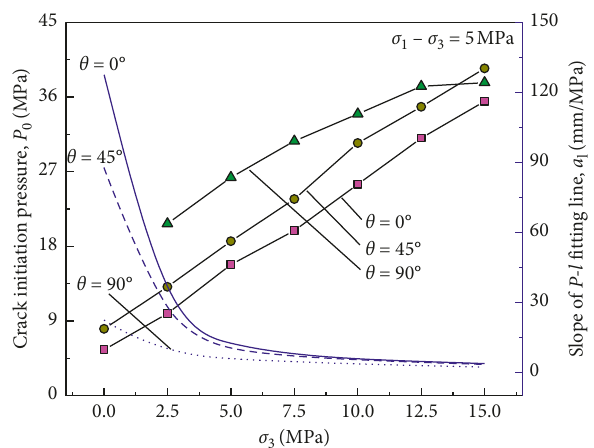
Figure 18: The variations of crack initiation pressure P slope of P - l linear fit a l versus σ 3 under different notch direction